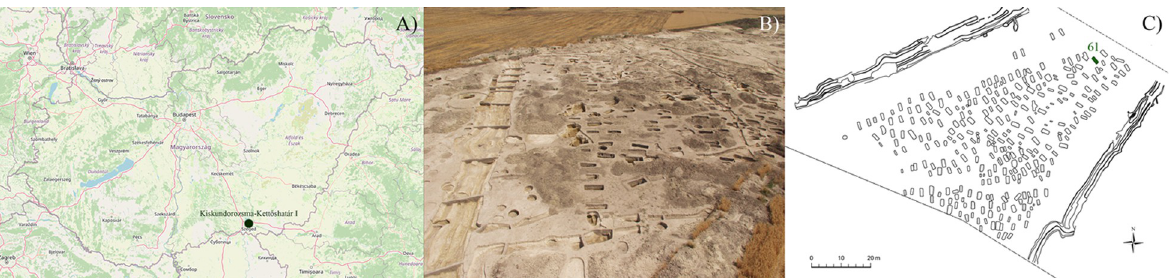
Fig 1. A) Map of Hungary showing the location of the Kiskundorozsma–Kett ő shata´r I archaeological site; B) Aerial photo of the Kiskundorozsma– Kett ő shata´r I archaeological site; and C) Plan drawing of the late Avar Age cemetery of Kiskundorozsma–Kett ő shata´r I with the location of the burial of KK61. (Fig 1A contains information from OpenStreetMap and OpenStreetMap Foundation, which is made available under the Open Database